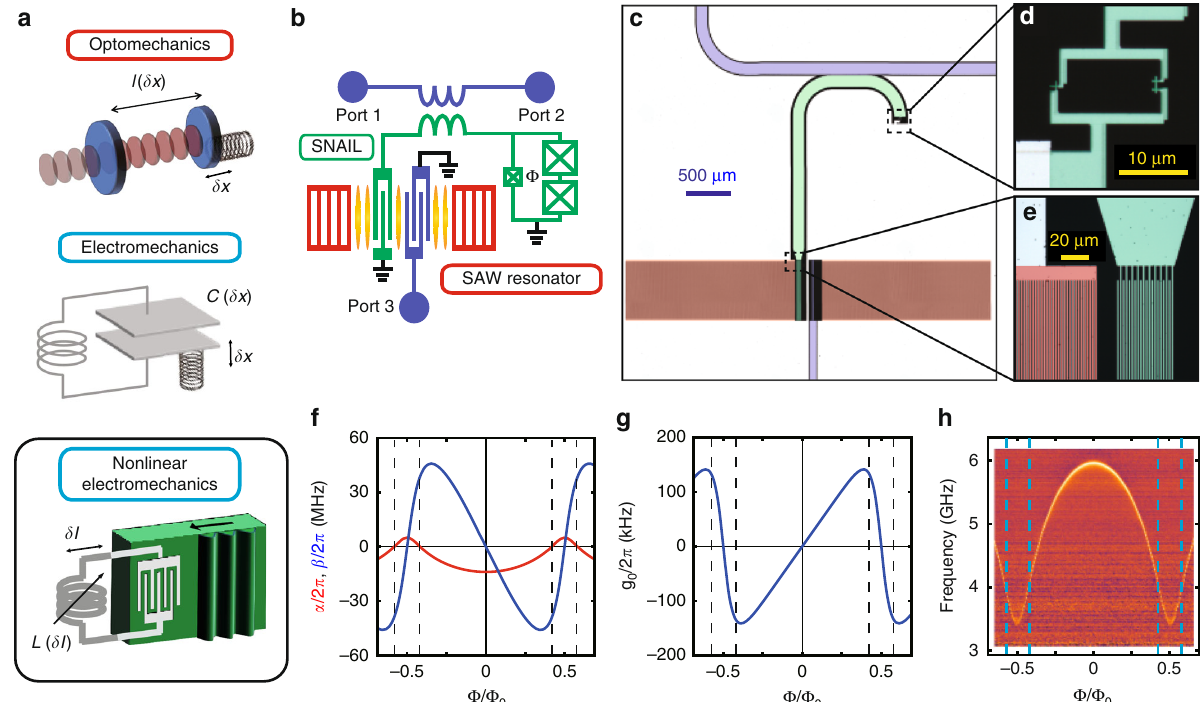
Fig. 1 SAW – MW hybrid system for arti fi cial radiation pressure interaction. a Variety of optomechanical systems. (top) Optomechanical system using an optical cavity. The effective cavity length l is modulated by the displacement of the mechanical oscillator δ x . (middle) Electromechanics using a microwave lumped-element circuit. The capacitance C is modulated by the displacement of the mechanical oscillator. (bottom) Electromechanics with a nonlinear Josephson junction circuit and a SAW resonator. The inductance L is modulated by the current induced by transduction from acoustic waves. b Schematic of the SAW optomechanical system. A SAW resonator de fi ned by Bragg mirrors (red) couples to a nonlinear MW resonator (green) via an interdigitated transducer. A SNAIL loop consisting of three Josephson junctions works as a nonlinear inductive element. Ports 1 and 2 are external feed lines for the MW resonator, and port 3 is that for the SAW resonator having a spatial mode shown in yellow. c – e False-colored micrographs of the sample. The colors of the electrodes correspond to the ones in the schematic in b . d Magni fi cation of the SNAIL part. The three junctions form the SNAIL loop. e Zoom-up of a part of the SAW resonator and the interdigitated transducer. f Calculated nonlinearity of the MW resonator as a function of the magnetic fl ux Φ penetrating through the SNAIL loop. Red (blue) curve represents the self-Kerr (Pockels) nonlinearity α ( β ) of the MW resonator. g Calculated strength g 0 of the arti fi cial radiation pressure interaction induced by the nonlinearity of the SNAIL. h Spectrum of the nonlinear resonator as a function of Φ measured with a weak MW probe whose average intra-resonator photon number is much less than unity. Vertical dashed lines in f – h indicate fl ux bias conditions where the self-Kerr nonlinearity vanishes in the numerical